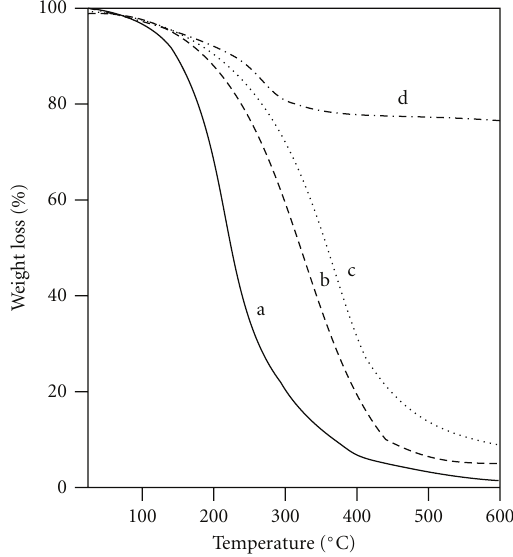
Figure 4: TGA of (a) PAN, (b) PAN/MMT (5%w/v) nanocompos- ite, (c) PAN/MMT (10%w/v) nanocomposite, and (d) MMT